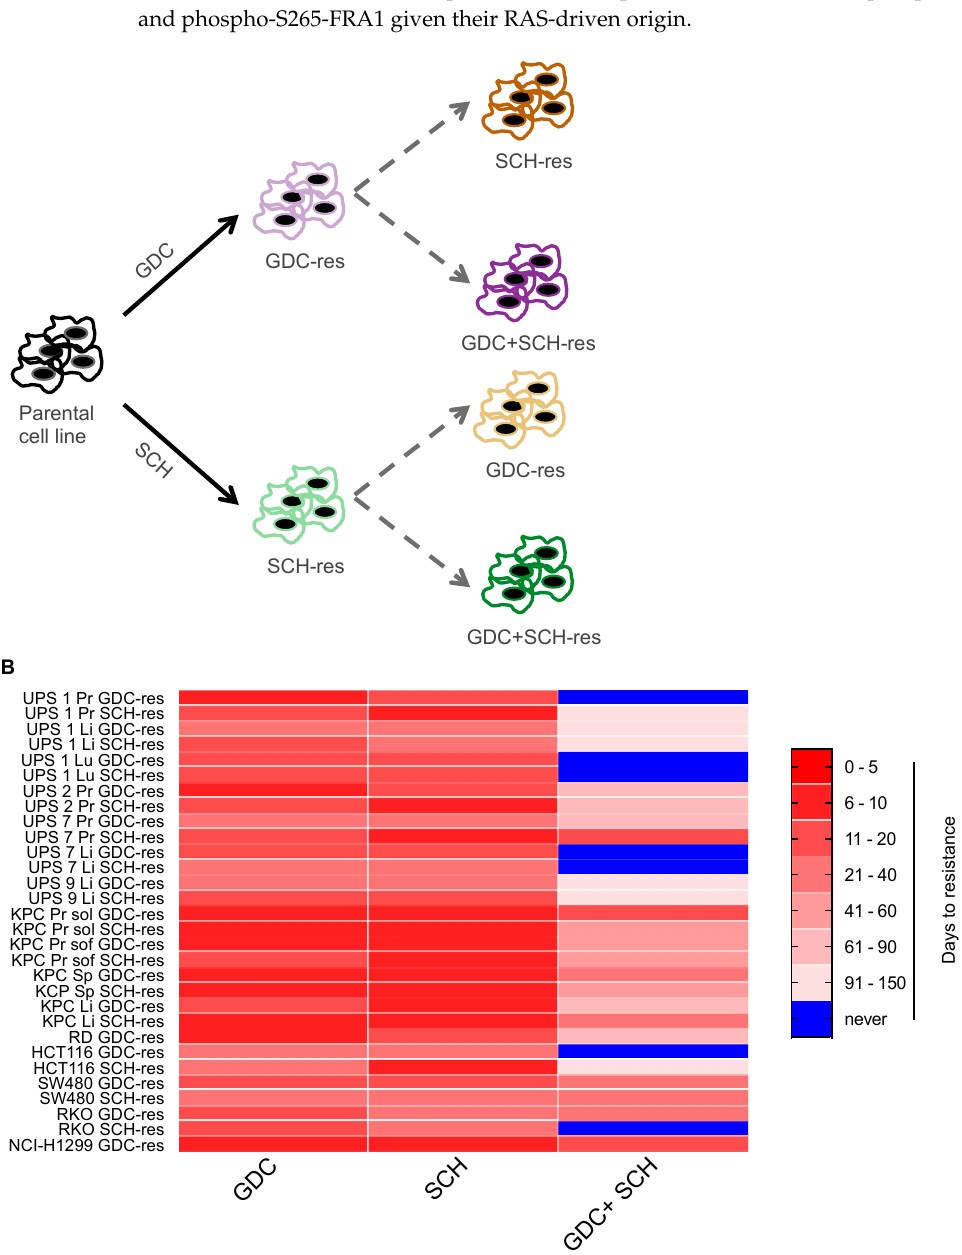
Figure 6. Cells resistant to MEKi or ERKi are frequently resistant to double inhibition. ( A ). Depiction of workflow used to generate secondary resistant cell lines. ( B ). Long-term drug resistance assay. The indicated sub-confluent cell lines (5 × 10 5 cells/6cm plate) were cultivated with the indicated inhibitors (1 μ M). Days to resistance represents the timepoint at which cells were first split and continued proliferation thereafter, cells that did not survive the treatments or proliferate within 4 months are depicted in blue.